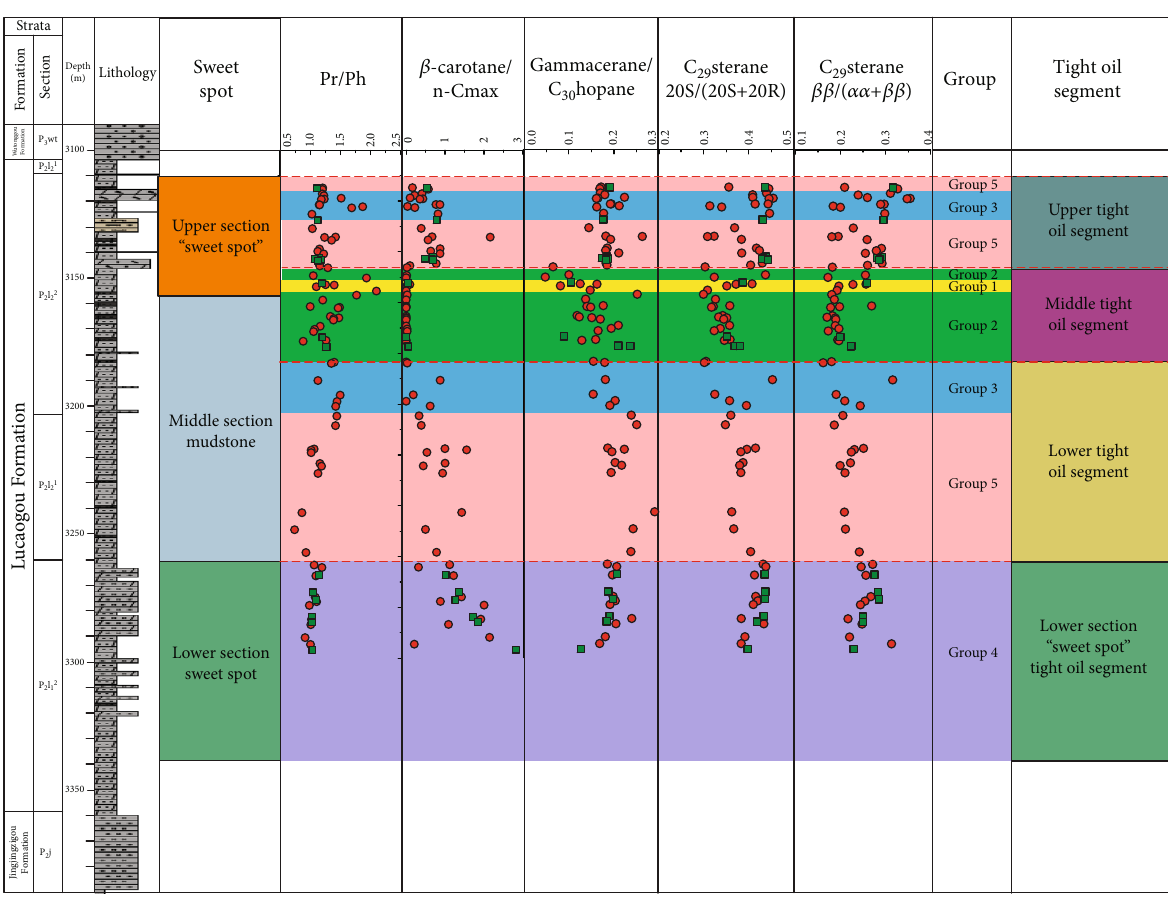
Figure 6: Relationship between the clustering of tight oil accumulation and the upper and lower sweet spot regions in the Lucaogou Formation, from Well Ji 174 in the Jimusar